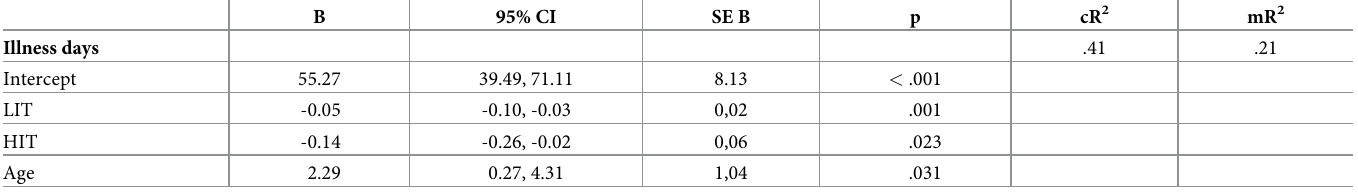
Table 4. Fixed-effects estimates (B) with 95% confidence intervals (CI), standard errors (SE) and p values for the effects of low-intensity training (LIT) volume, high-intensity training (HIT) volume and age on number of self-reported illness days.